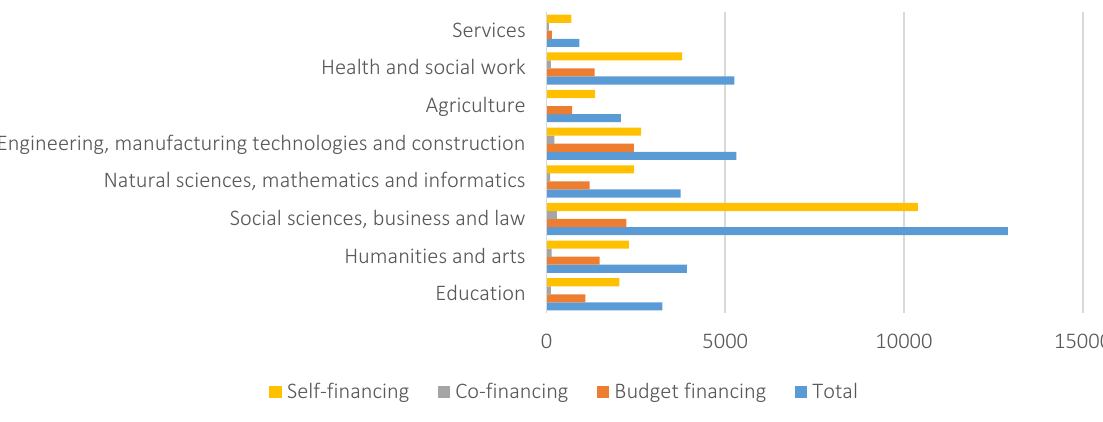
Figure 5. The number of students by scientific fields and according to the method of financing in the academic year